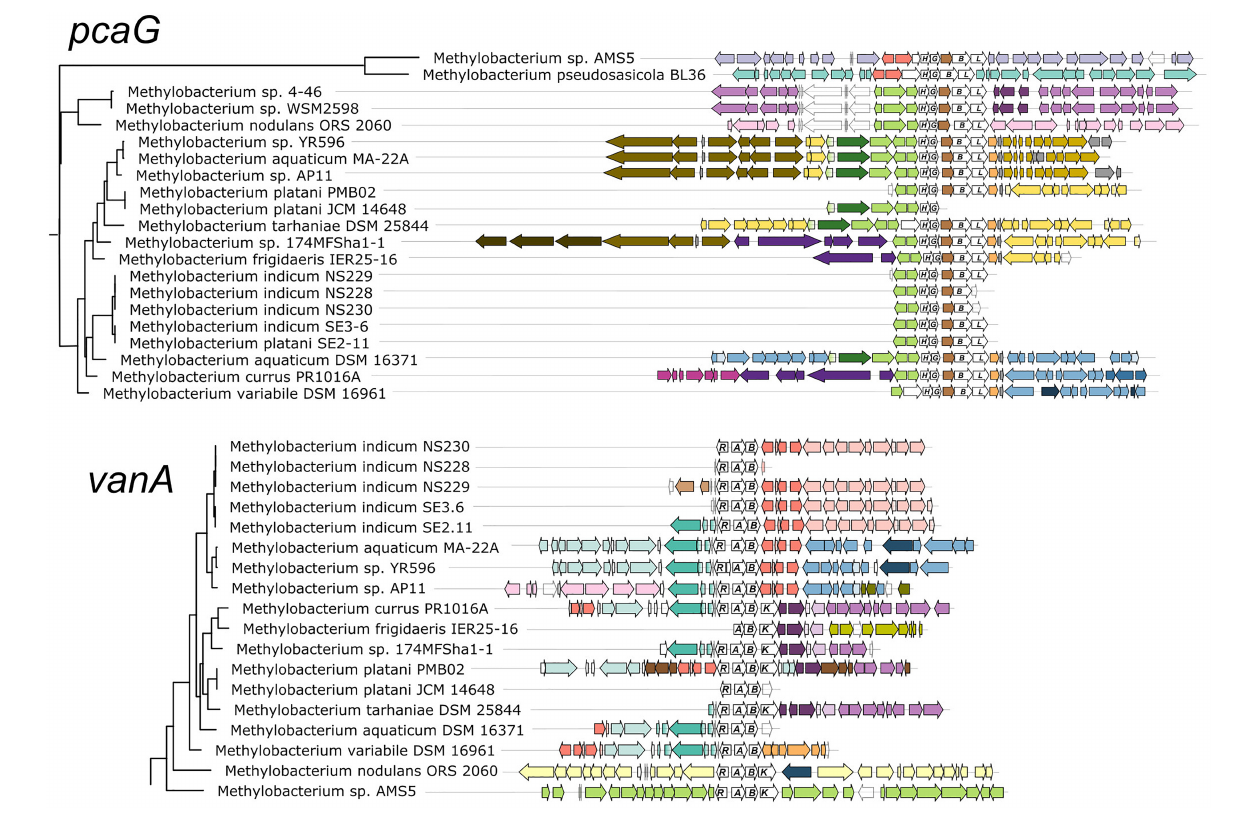
FIGURE 3 | Genomic context of aromatic catabolism genes in Methylobacterium species supports a common evolutionary origin within the M. aquaticum/nodulans clades and separate origin in M. pseudosasiacola and Methylobacterium sp. AMS-5. Genomic regions (from fully assembled genomes) or scaffolds (from partially assembled genomes) showing the neighborhoods of pcaG and vanA were aligned at the genes of interest. Gene phylogenies are excerpted from Figure 2 . Genes of interest and their operons are shown in white with gene names labeled. Within each of the two alignments, homologous regions shared across multiple genomes are shown in the same color to facilitate comparison among genomes. In most cases, members of the M. aquaticum clade share some synteny in the regions surrounding the van and pca gene clusters, with the degree of synteny roughly paralleling their phylogenetic distance. Exceptions indicate likely cases of horizontal gene transfer, in agreement with figure.